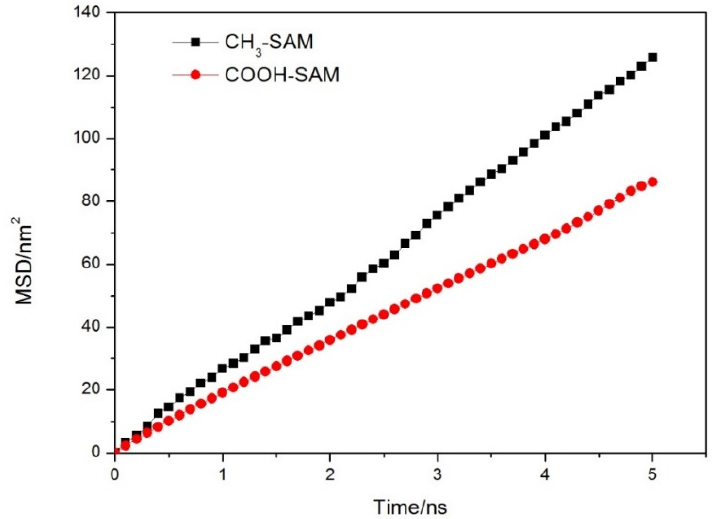
where N represents the number of target molecules in the system, the coordinates of the ith particle at 0 and t , respectively.